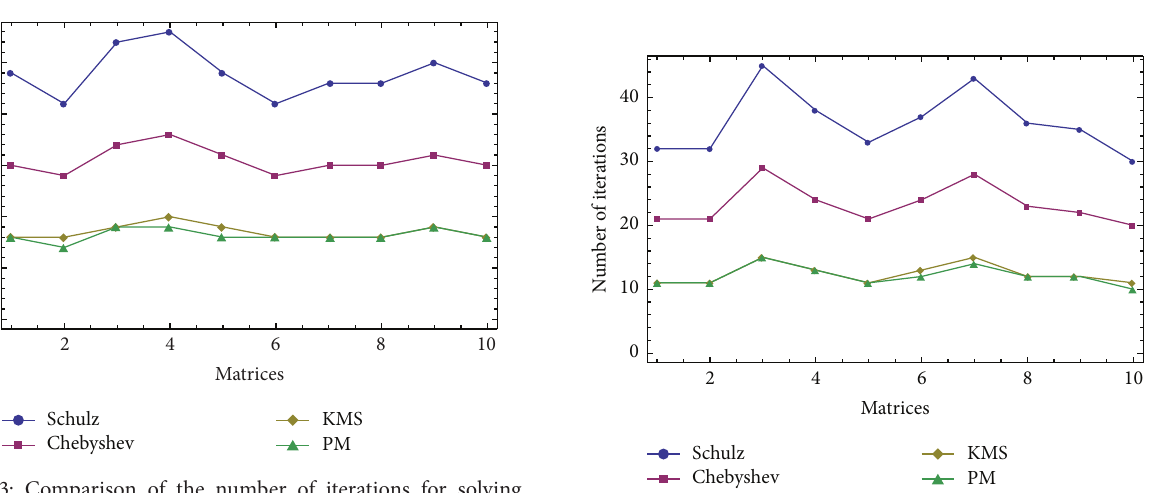
Figure 5: Comparison of the number of iterations for solving Example 10.